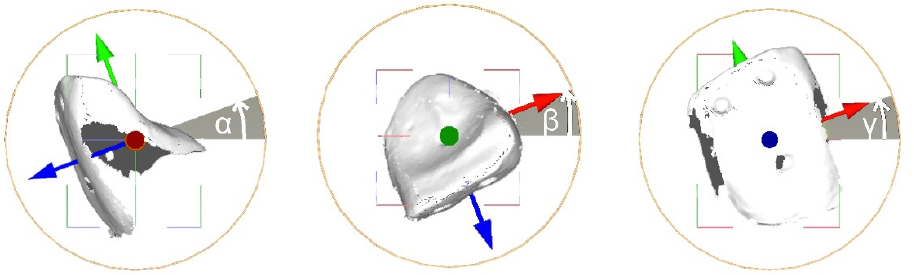
Figure 3. Tooth movement calculation using MeshLab’s roto-translation matrix. The rotation angle was calculated with a rotation matrix according to “the roll, pitch and yaw convention” (accuracy ± 0.2